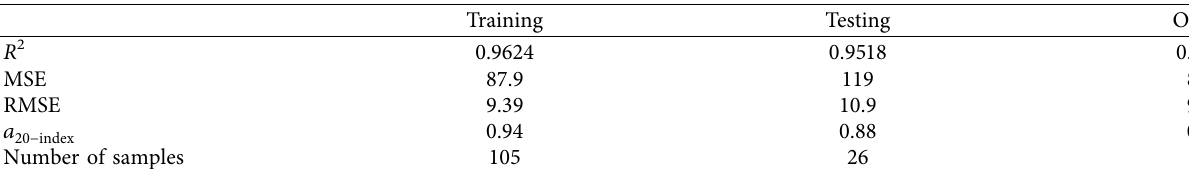
Table 7: Performance results of the ANFIS model.